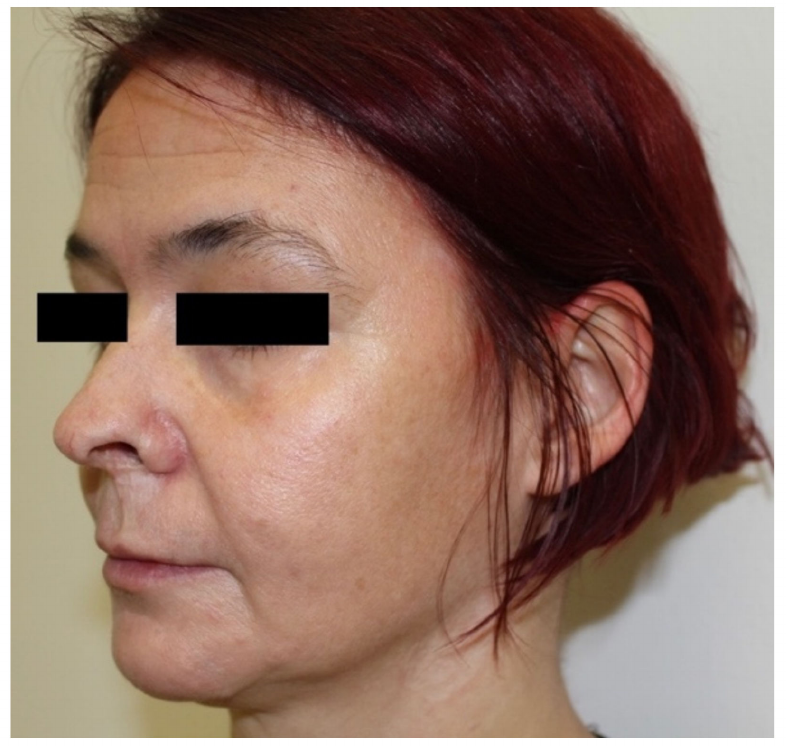
Figure 3. Residual scars on the face and neck 10 months after treatment of malignant